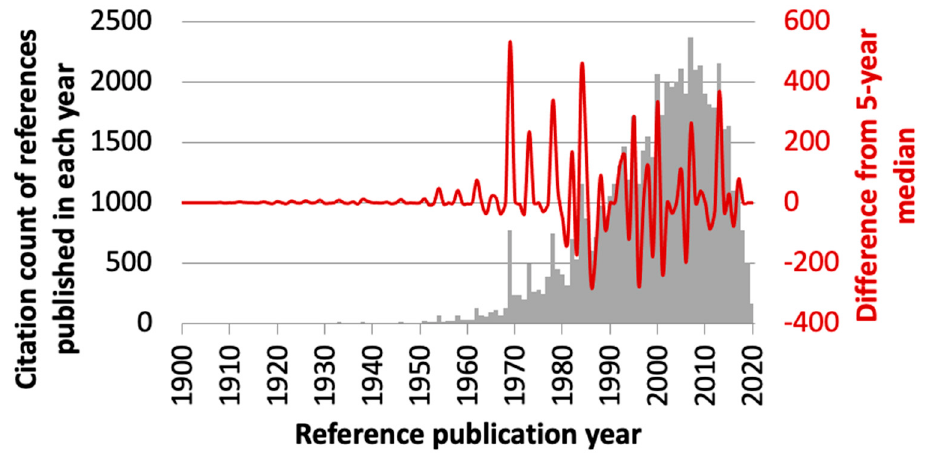
Figure 2. Reference publication year spectrogram (RPYS) created by analyzing 2119 papers on dental anxiety. The grey bar chart shows the citation count of references published in each publication year. The red wave form shows the citation differences from the 5-year median. Take the year 1969